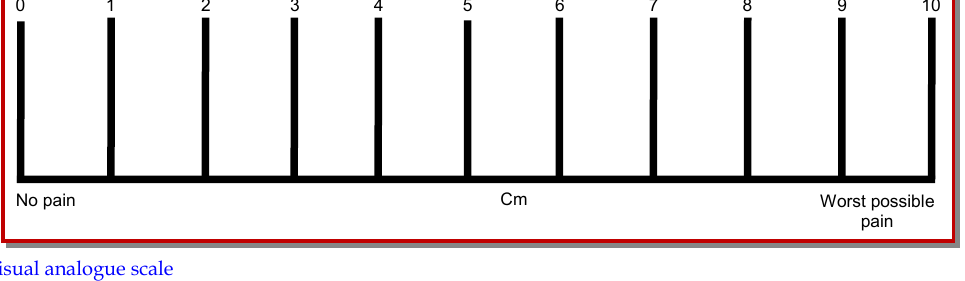
Figure 1: Visual analogue scale